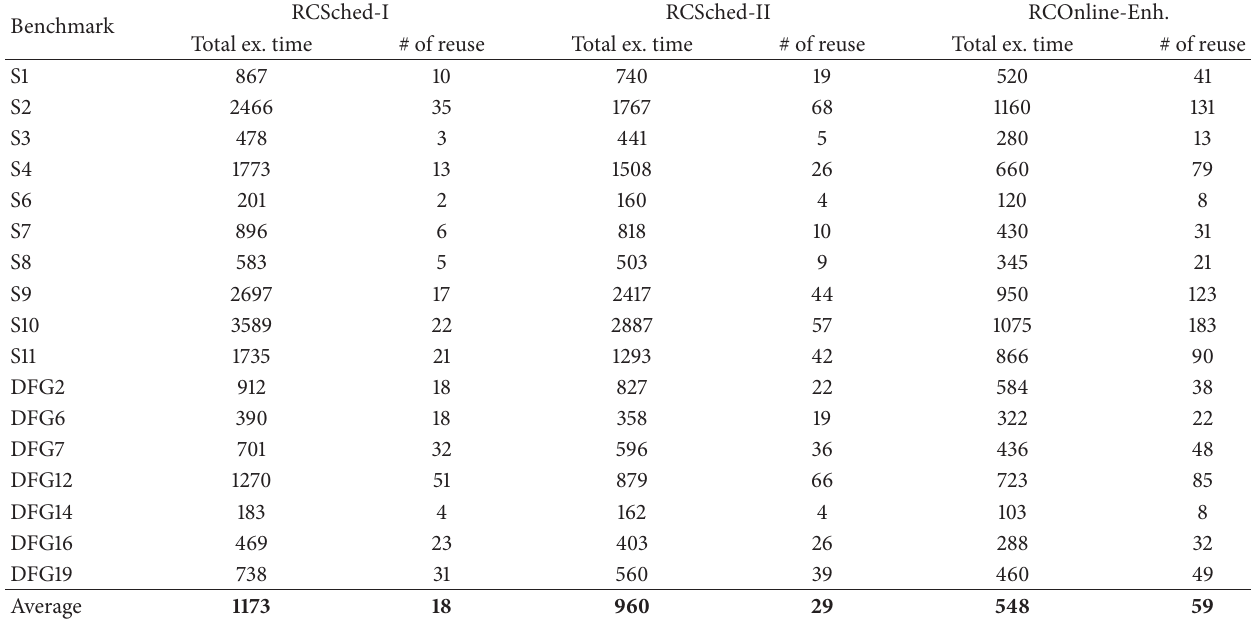
Table 7: Comparison of schedulers based on execution time and number of hardware reused tasks.